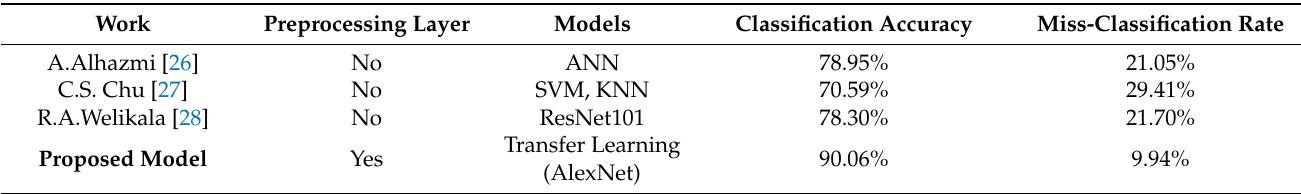
Table 7. Comparative analysis with previous